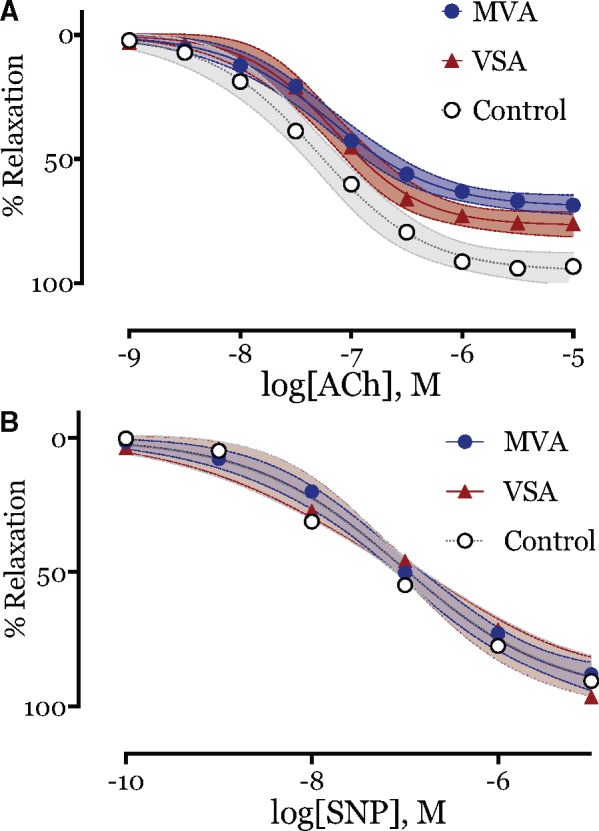
Cumulative concentration-response curves to dilator agonists. (A) Endothelial function assessed by acetylcholine showing impairment in vasorelaxation in both microvascular angina subjects (blue circle; acetylcholine Emax 77.6%, n = 48; P < 0.01) and vasospastic angina subjects (red triangle; acetylcholine Emax 79%, n = 9; P = 0.03) vs. control subjects (○—white circle, Emax 98.7%, n = 10). No difference in acetylcholine Emax between microvascular angina and vasospastic angina subjects (P = 0.967). Comparison of CCRC fit, P < 0.001. (B) No difference in vasorelaxation to endothelial independent probe, sodium nitroprusside between microvascular angina patients (blue circle, sodium nitroprusside Emax 97%, n = 49), vasospastic angina subjects (red triangle; acetylcholine Emax 99%; n = 10) and control subjects (○—white circle, Emax 98%, n = 10; P = 0.99). Each measure represents mean ± 95% confidence intervals for mean in shaded contours from CCRC best-fit. No difference in response to sodium nitroprusside between the groups, P = 0.4914.